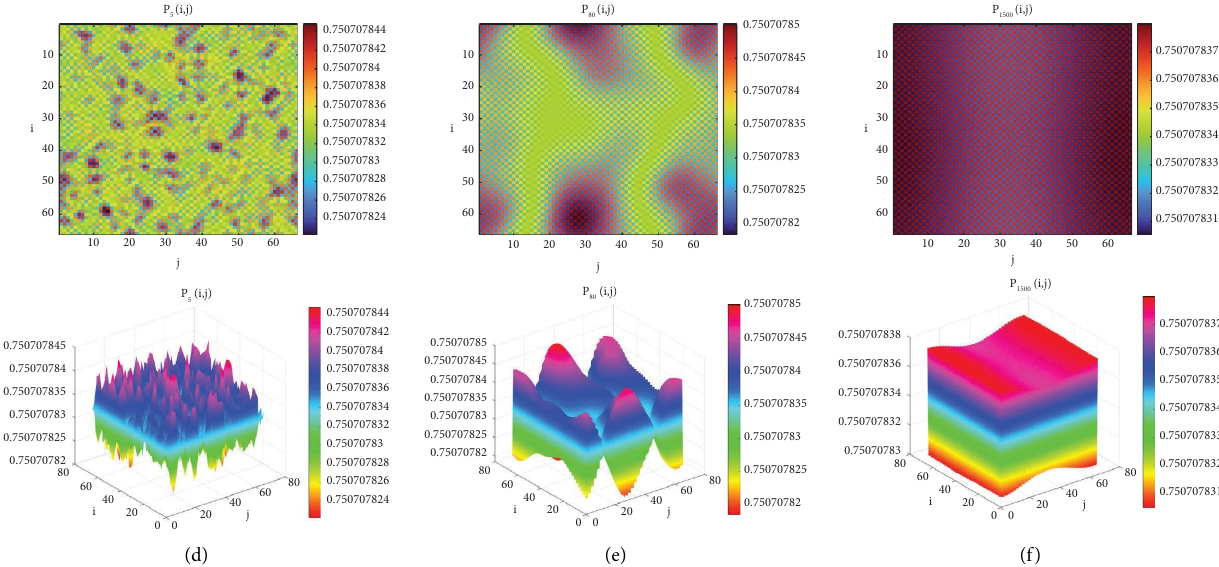
Figure 18: R � 2 , k � 1, c � 0 . 8, σ ∗ � 0 . 278655, σ � 0 . 5, ( d which is consistent with the case of Corollary 3(5), a 1: 2 Resonance occurs, parasite and host populations exhibit unstable period-doubling oscillations in two-dimensional space.